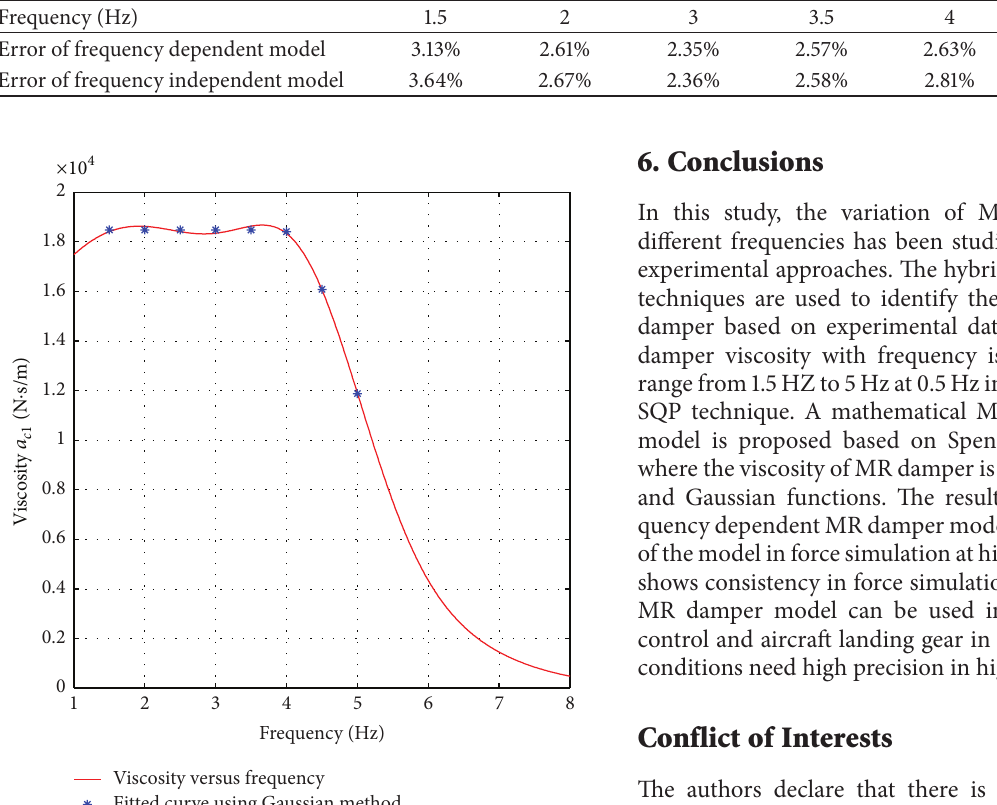
Table 3: Comparison between frequency dependent and original Spencer model.